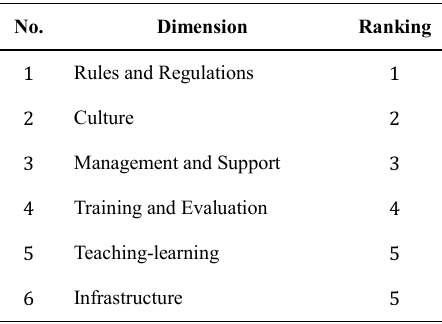
Table 7. Dimension ranking using AHP